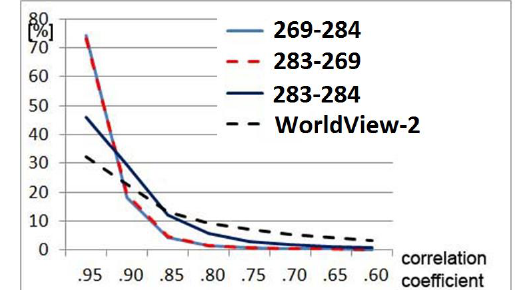
Figure 11. Frequency distribution of correlation coefficients for the different image